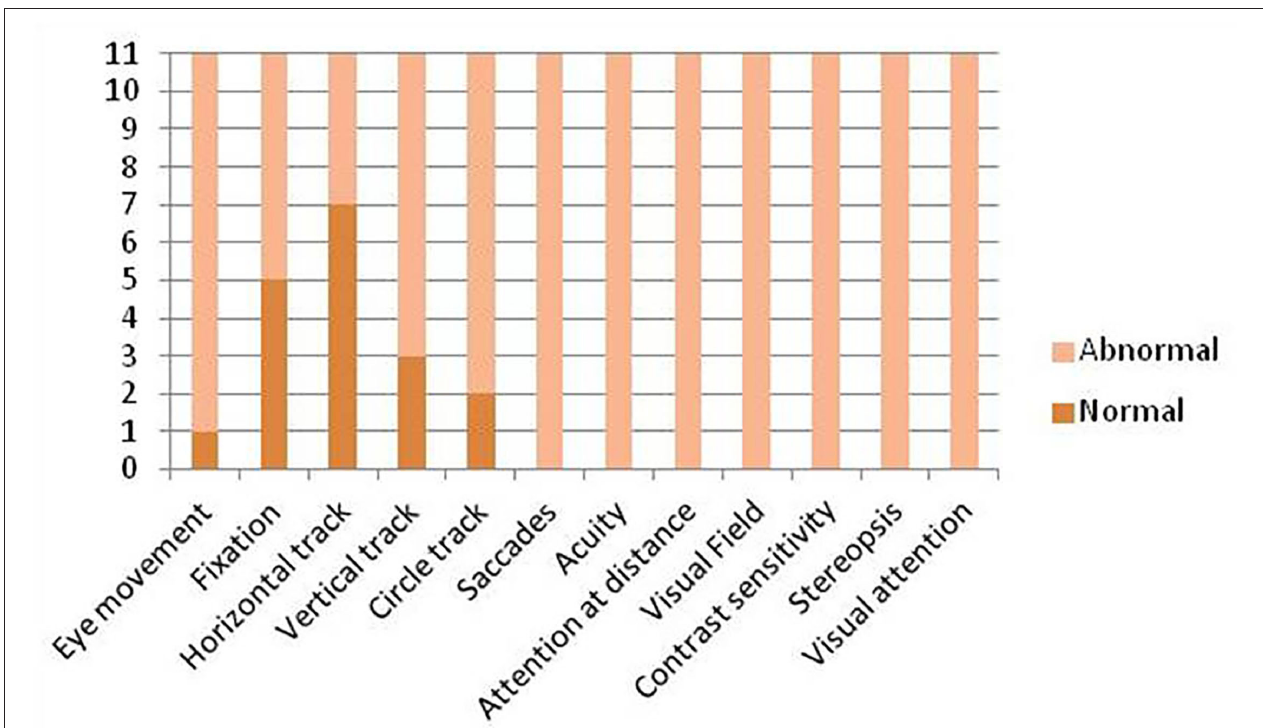
FIGURE 1 | Visual function